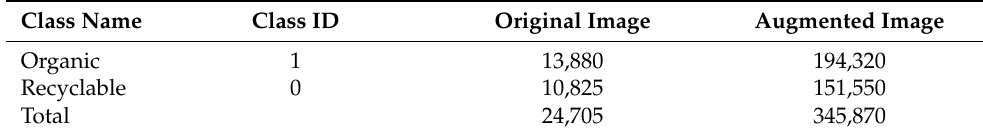
Table 1. Characteristics of the original and augmented experimental